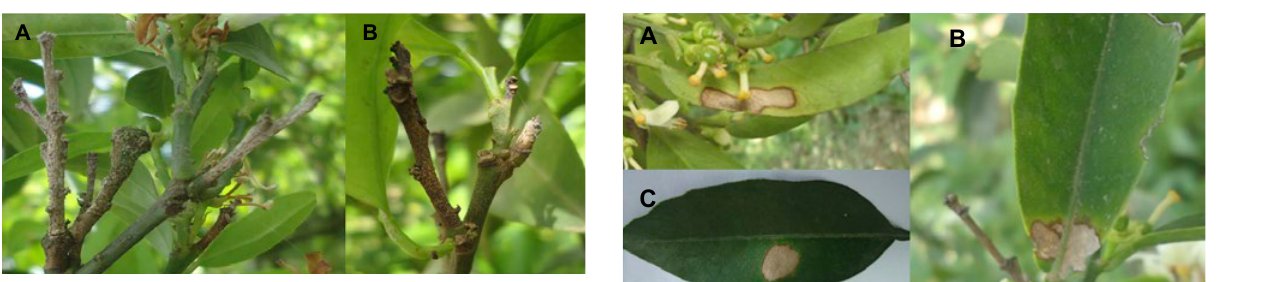
Figure 3. Anthracnose symptoms on leaves of clementine (A, B and C).